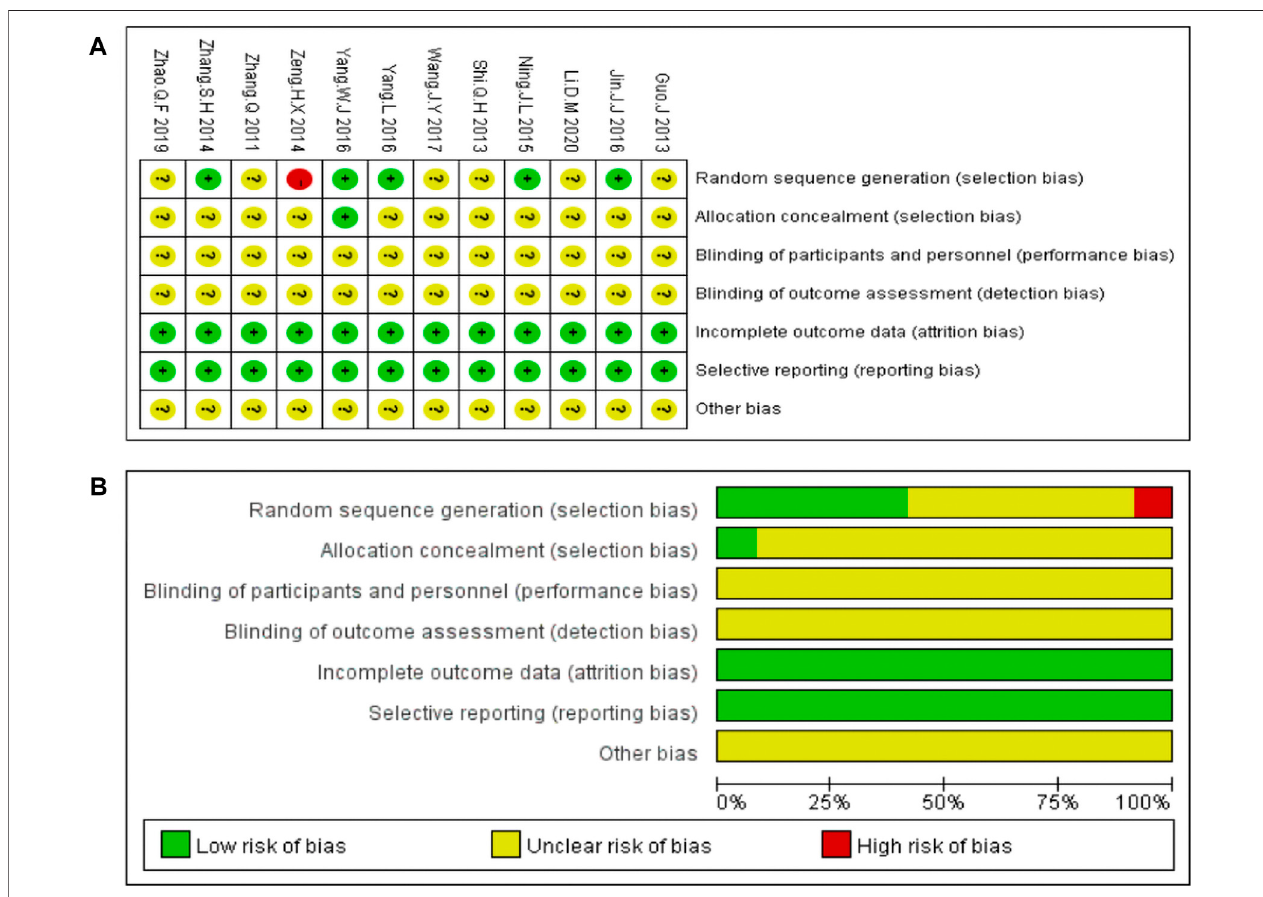
FIGURE 3 | Risk of bias of the included studies (A) Risk of bias graph (B) Risk of bias summary.